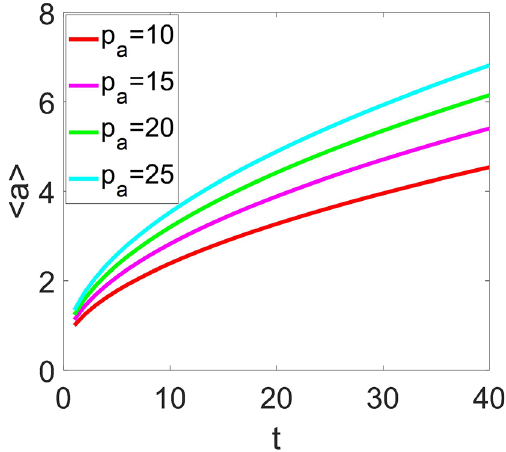
Fig. 3 Variations in the average value of the scale factor ( (cid:7) a (cid:2) ). The horizontal and vertical axes represent the time variable and (cid:7) a (cid:2) , respec- tively. The parameters are taken as: p a = 10, α = 0 . 5, V 0 =